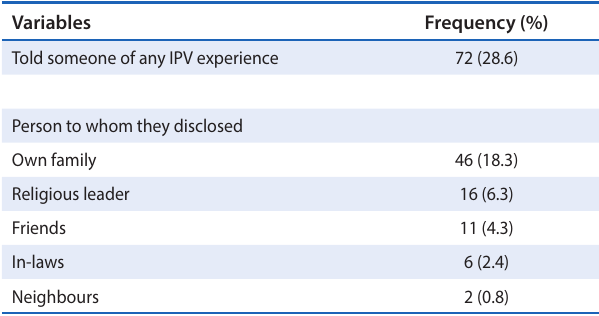
Table 4: Distribution of respondents who told someone of their IPV experience ( n = 252)*